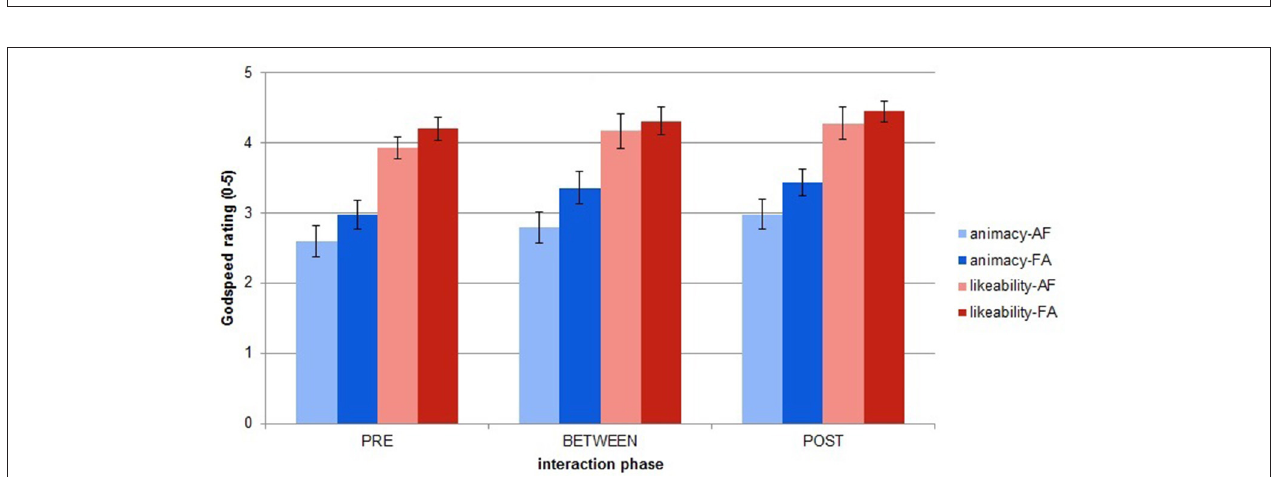
FIGURE 8 | IOS ratings averages across order and phases. Error bars represent standard error. Asterisks indicate significant difference.